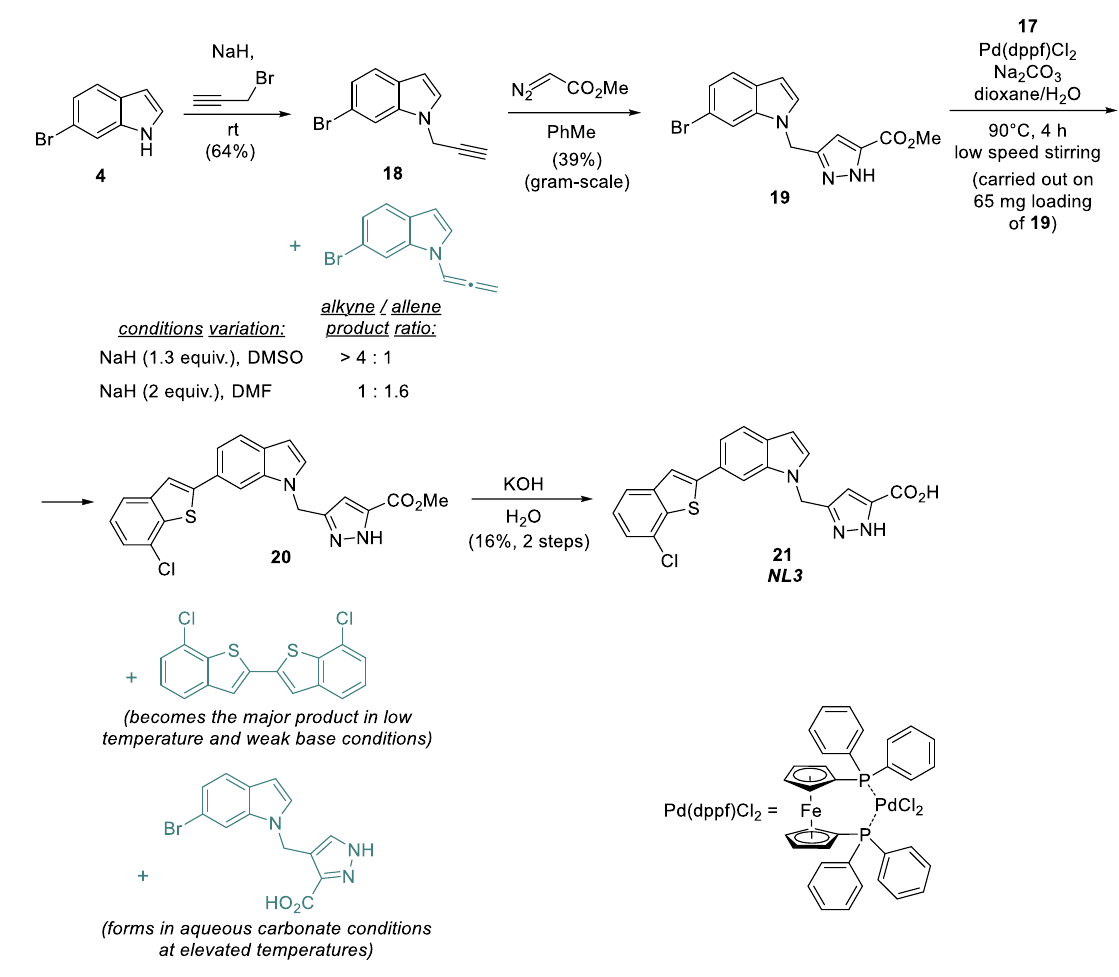
Figure 6. Synthesis of the NL3 inhibitor.